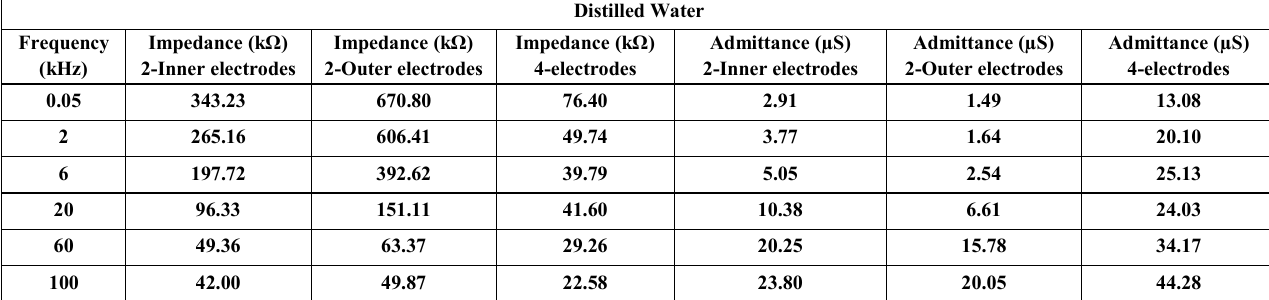
Table (5) the influence of the three experimental setups (2-Inner, 2-Outer and 4- Electrodes) on the impedance and admittance values. Distilled